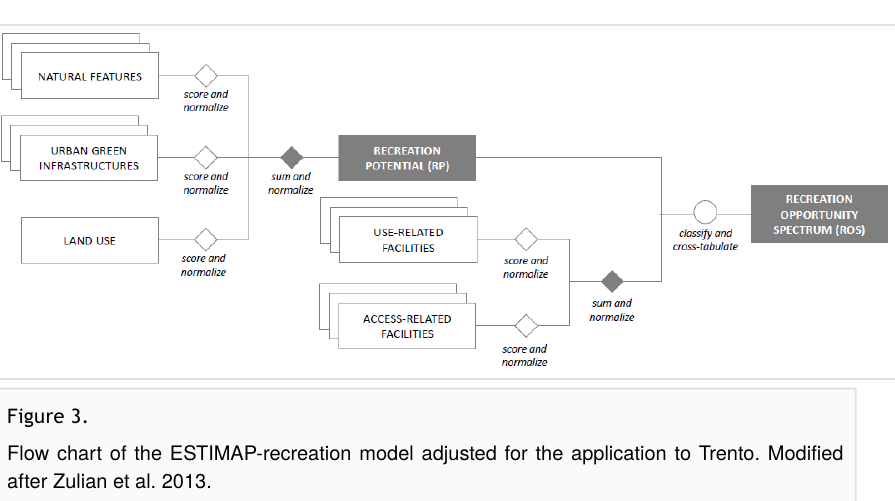
Flow chart of the ESTIMAP-recreation model adjusted for the application to Trento. Modi fi ed after Zulian et al.